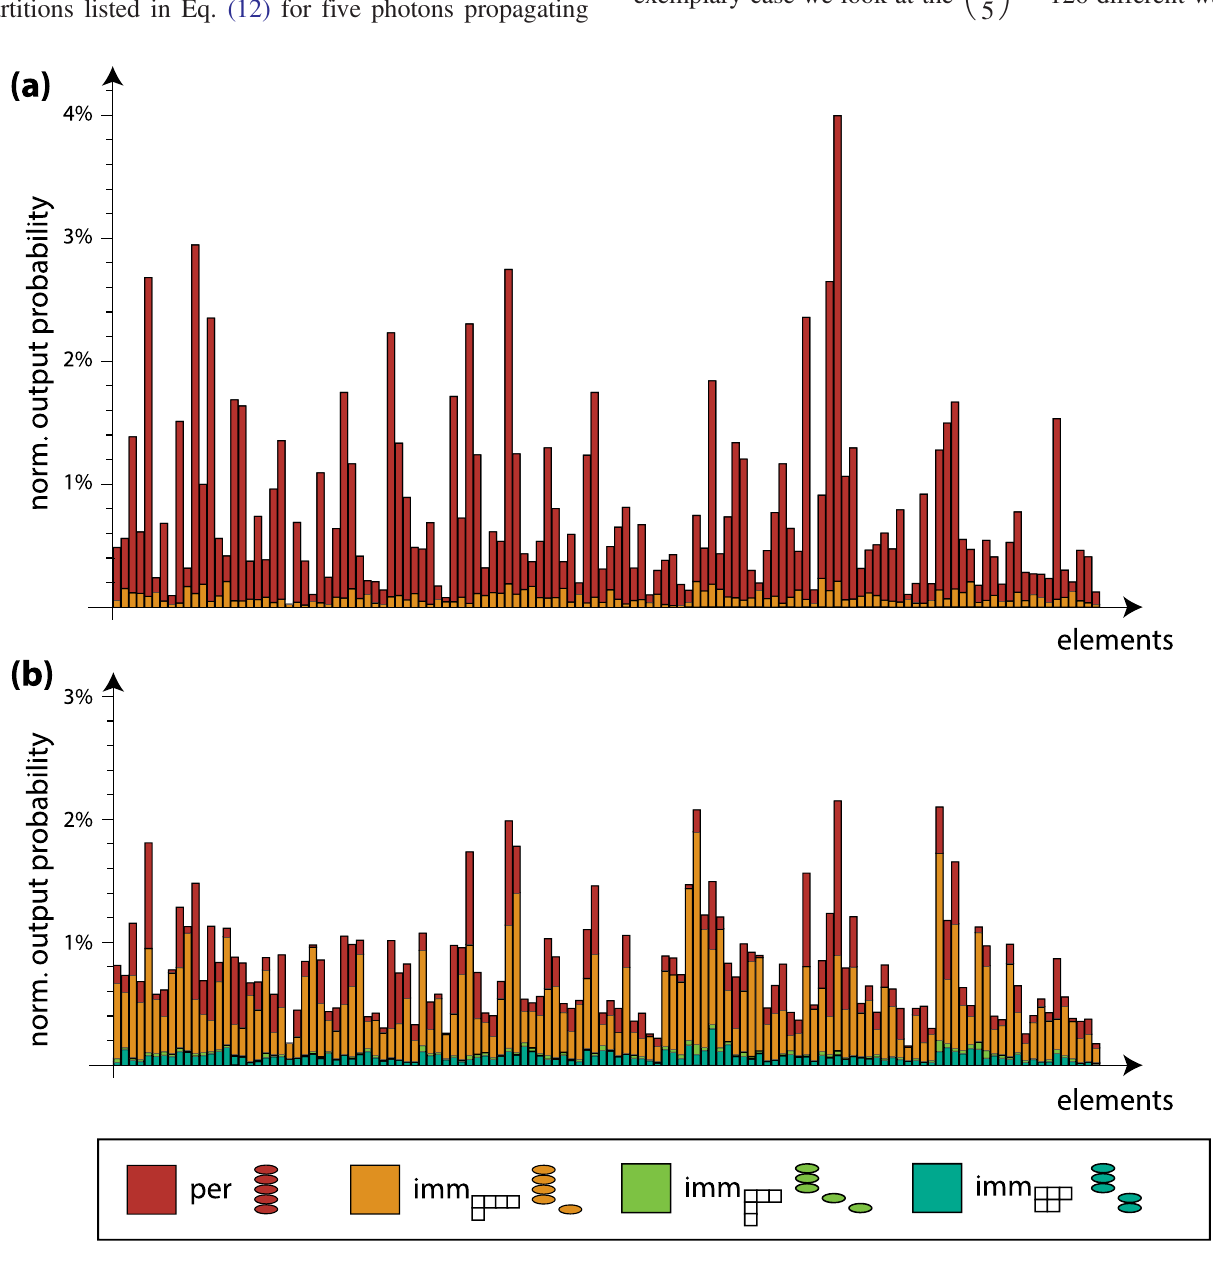
FIG. 5. Five-photon BosonSampling including distinguishability. Simulation of a BosonSampling instance of five photons propagating through an interferometric network of nine modes. The output probability distribution of five photons exiting the interferometer in five different modes is normalized and contains 126 elements. Owing to the large size of this probability distribution, we choose not to list them individually, and we label the horizontal axes by “ elements. ” Panel (a) depicts the close-to-the-ideal case where realistic errors such as slight spectral mismatch and temporal delay ( Δ τ distinguishability. Panel (b) shows a case where the interfering photons exhibit increased partial distinguishability ( Δ τ exemplary output probability distributions [(a) and (b)], contributions from permanents (per) and immanants ( , , ) arise. The immanant contributions cover physical scenarios with different symmetries under exchange of five photons. The labels of the immanants describe the number of photons that are distinguishable. , for instance, is the contribution from the case when four photons are indistinguishable from one another but distinguishable from the fifth